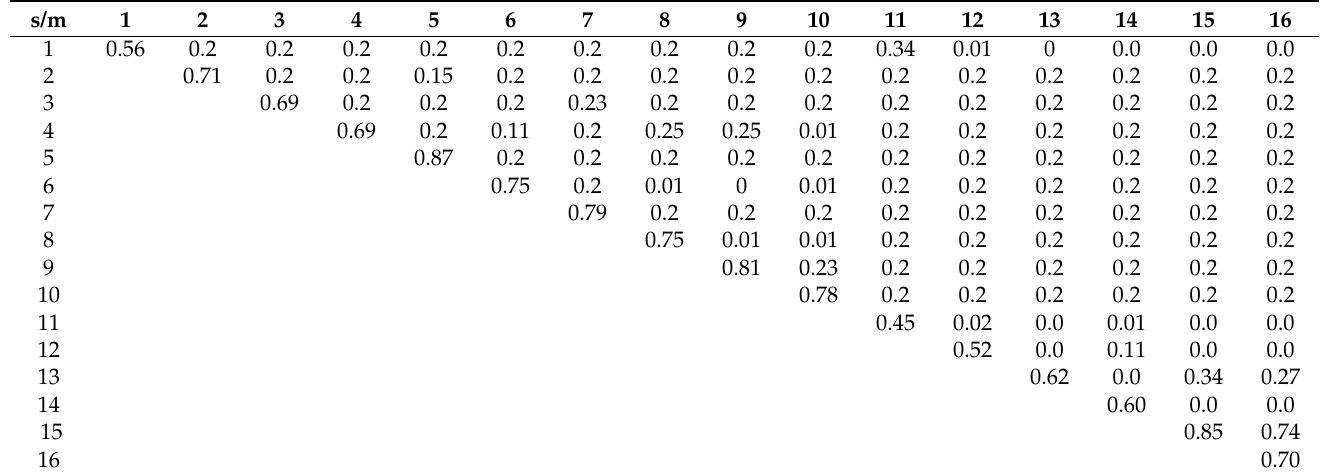
Table 6. Value of similarity index E s , m for all the pairs of nodes of Kaatiala mine map, with noise